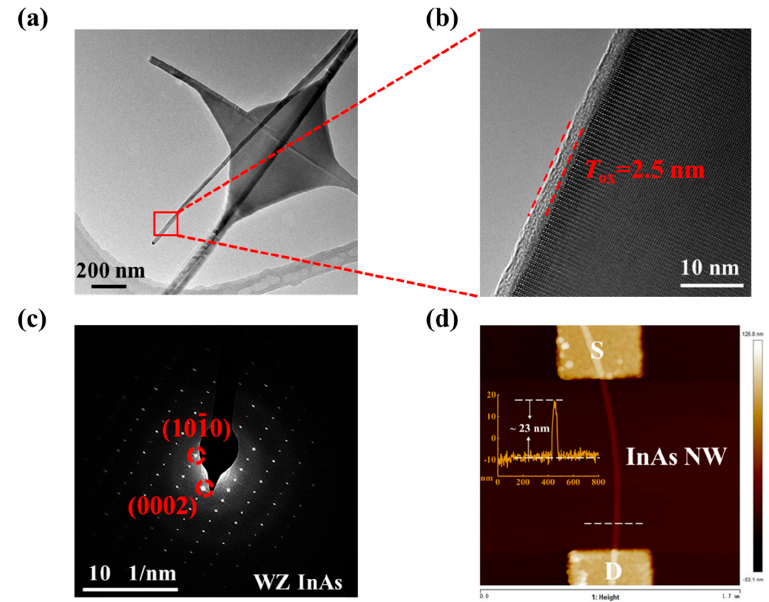
Figure 1. ( a ) Transmission electron microscopy (TEM) image of the as-grown InAs NWs. ( b ) High- resolution transmission electron microscopy (HRTEM) image of the InAs NW outlined in ( a ) by a red square. The thickness of the native oxide layer is 2.5 nm, as marked by the dashed lines. ( c ) Electron diffraction pattern of the NW shown in ( a , b ). The pattern is indexed to be [010] zone axis and the growth direction of the InAs NW is [0001],as marked by the dashed circle. ( d ) Atomic force microscopy (AFM) image of an InAs NW field-effect transistor, where the diameter of the NW is measured to be 23 nm.